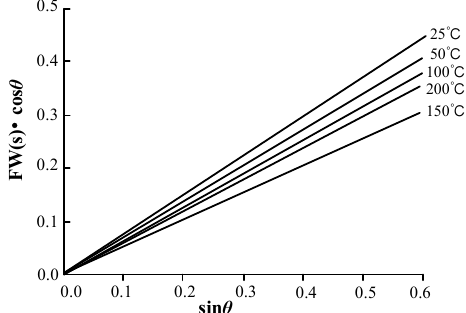
Figure 6. Microscopic strain graphic of the ZnO waveguide layer.